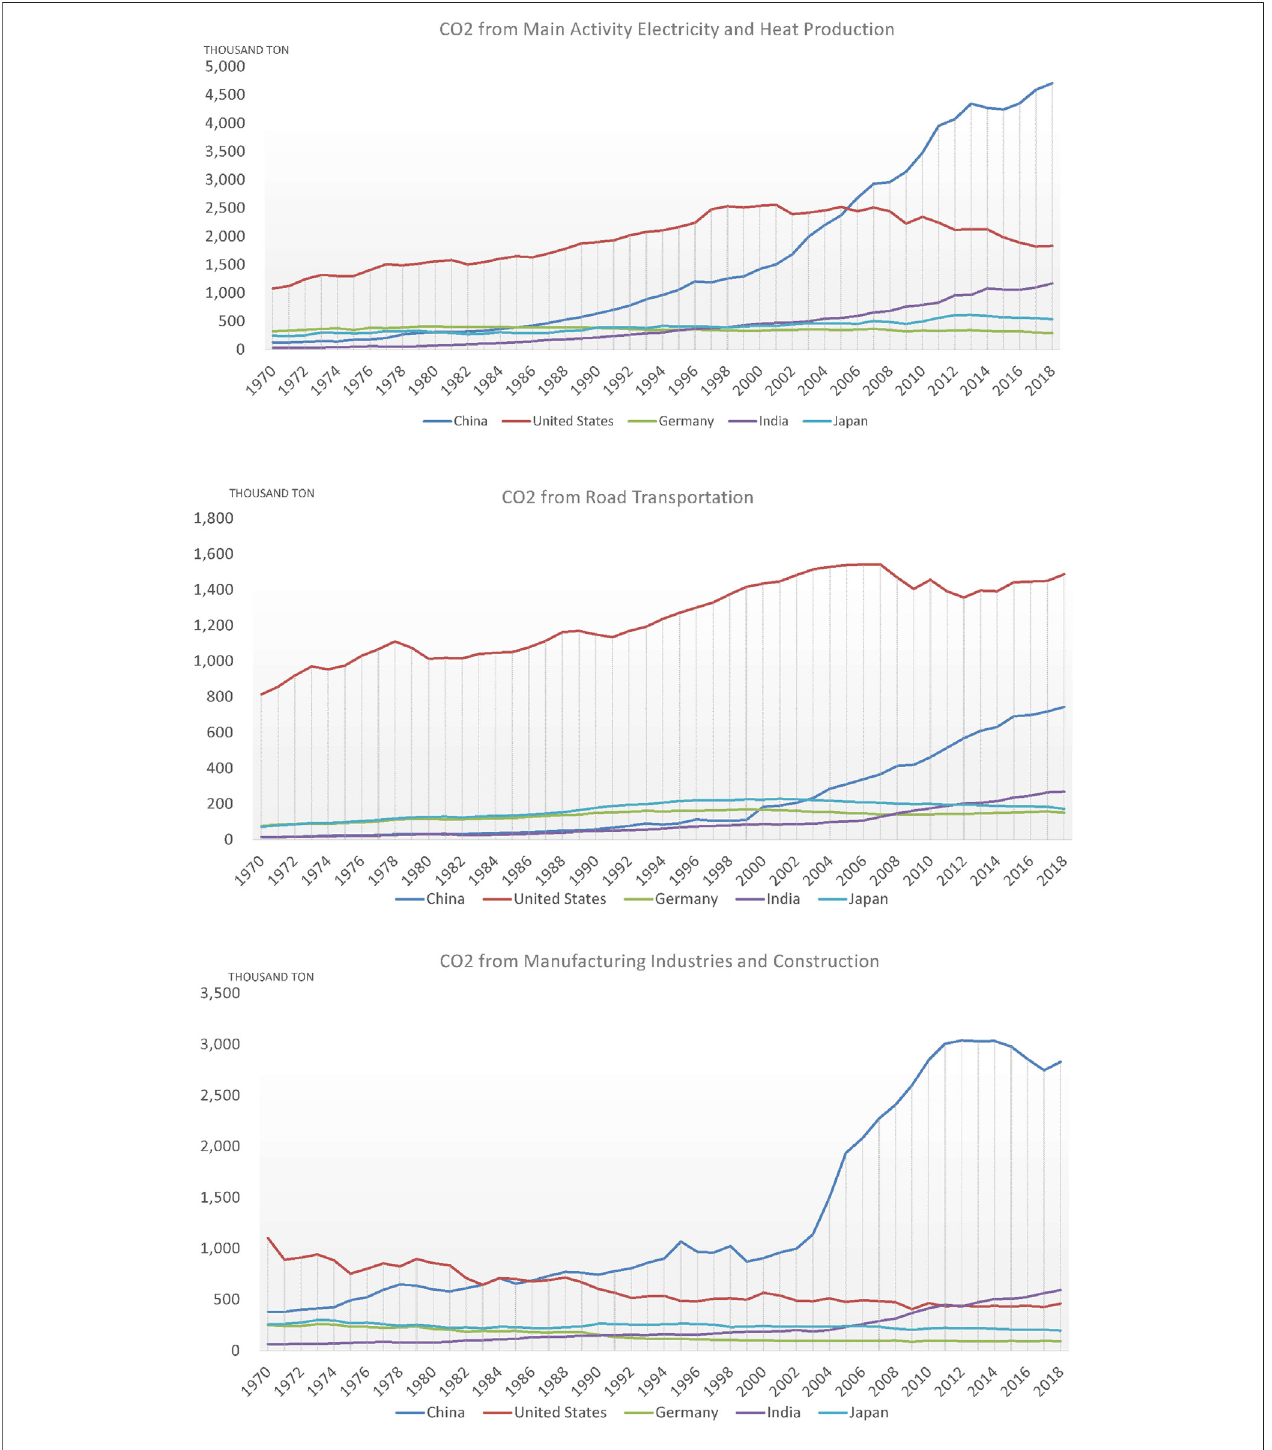
FIGURE 1 | Carbon emissions in different sectors.